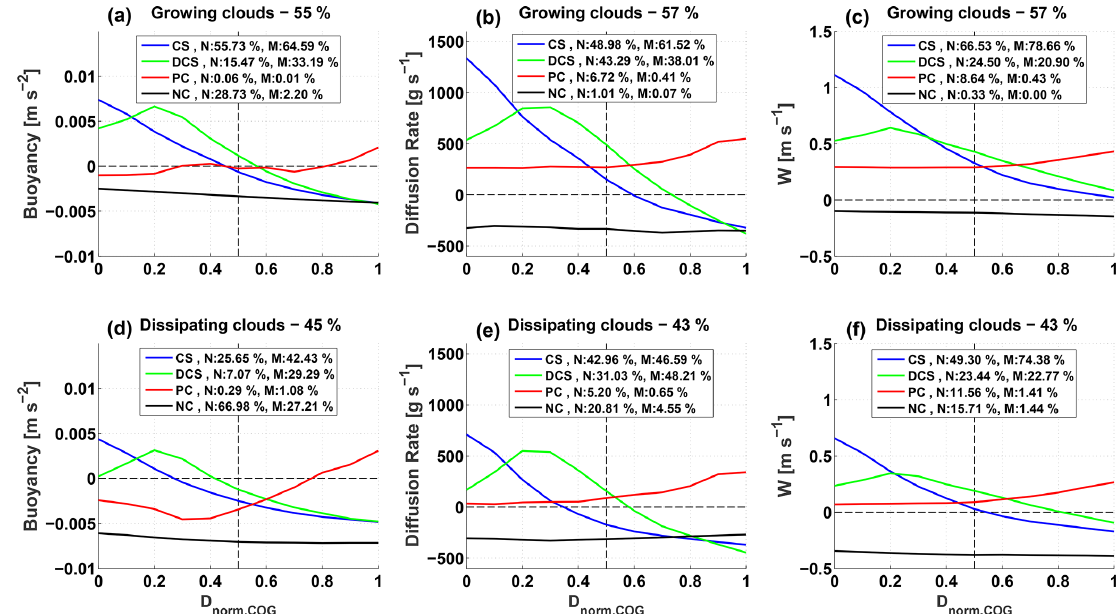
Figure 9. Mean horizontal profiles of core parameters from the cloud COG to cloud edge, for clouds with single cores and no cores. Data are divided into growing clouds (a, b, c) and dissipating clouds (d, e, f) , where the horizontal distances are normalized by the maximum distance to cloud edge. Parameters include buoyancy (a, d) , diffusion rate ( b, e ; taken as a proxy for the supersaturation core), and vertical velocity (c, f) . The data are divided to profiles that match core–shell (CS), displaced core–shell (DCS), peripheral core (PC), or no-core (NC) categories, as indicated by the different line colors. The percentages of cloud number ( N ) and cloud mass ( M ) attributed to each category are shown in the panel legends. We note that comparing the number percentages with mass percentages for each category gives an indication for the relative sizes of the clouds (e.g., higher N % than M % indicates smaller clouds).